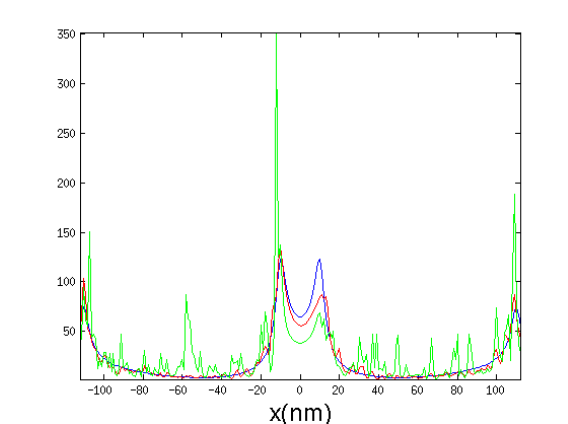
2 at 3 nm above E Figure 10: Intensity of the electric field | | the nanoantenna( — : biosensor with smooth surface, — : biosensor with rms roughness 0.82 nm and — : biosen- sor with rms roughness 1.41 nm; the gap between the two 10 to x = 10 nm) nanorods is from x = − roughness disturbed the distribution of electric field